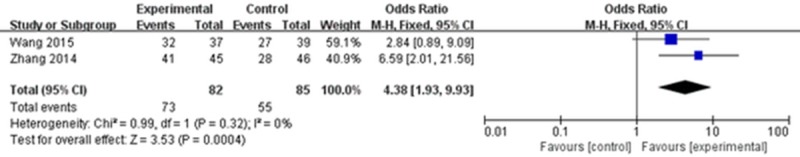
Forest plot of the improvement in defecation frequency (fixed effects model).